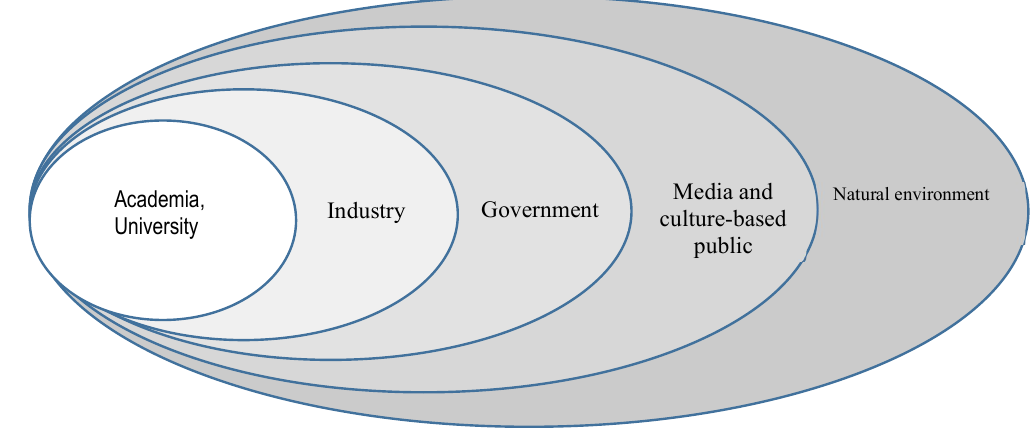
Fig. 1. The subsystems of the Quintuple Helix